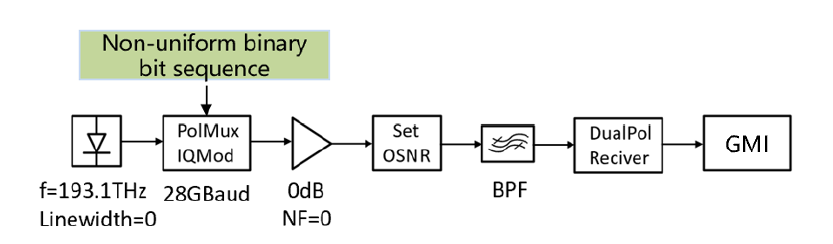
Figure 4. The GMI simulation block diagram and parameters in VPI.